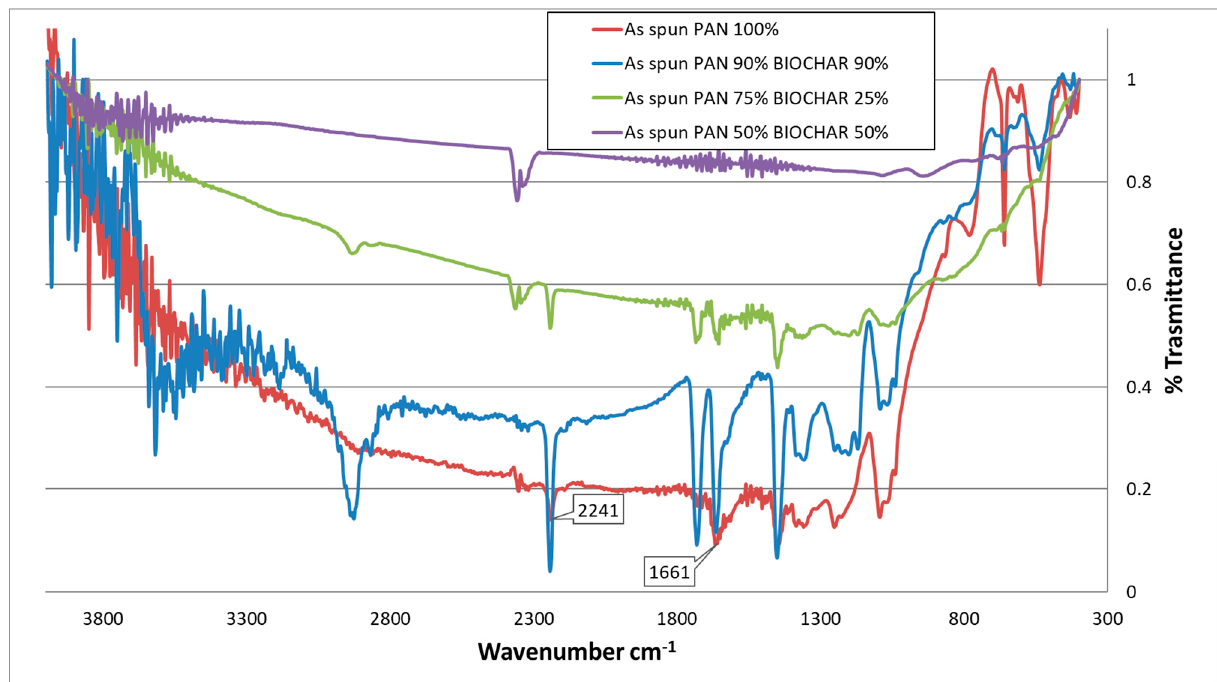
Figure 9. IR spectrum of “as-spun” fibers.